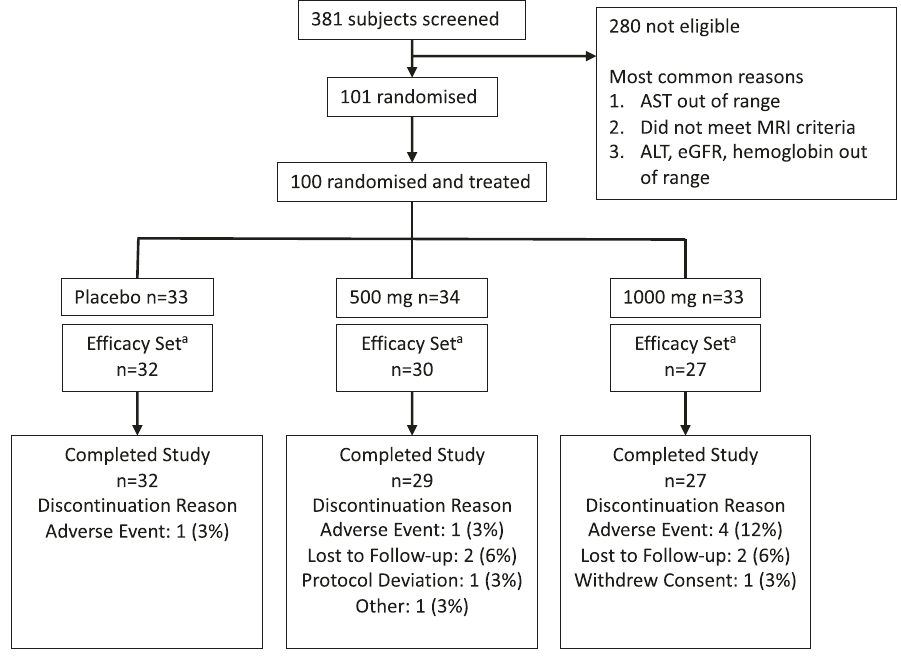
Fig. 1 Clinical study fl ow diagram. Clinical study fl ow diagram showing the disposition of subjects with presumed NASH and diabetes screened and enrolled into a randomised controlled trial of berberine ursodeoxycholate